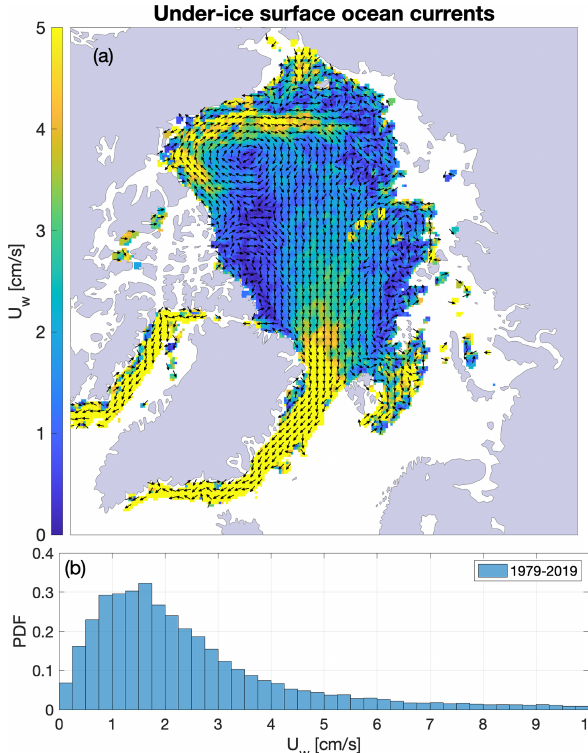
Figure 8. (a) Estimates of the oceanic surface currents over the 1979–2019 period, calculated as the ice motion unexplained by the wind, considering the α(h) parameterization for free drift. The dis- tribution of the current speed is presented in panel (b) . For any given grid cell, the surface current is optimized as an intercept in a best linear fit between the IABP buoys sea ice drift and the ERA5 10m